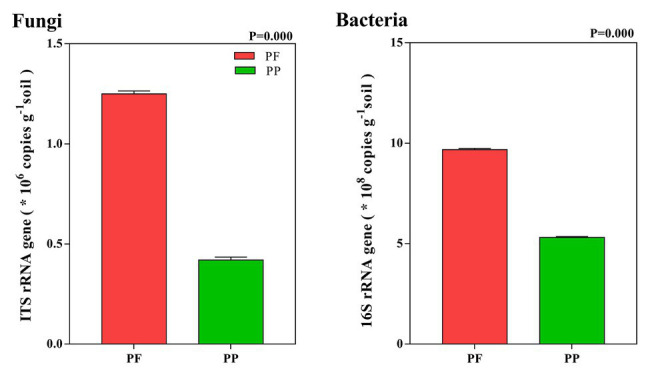
Total abundance of fungil and bacteria in PF mixture and PP monoculture soils.